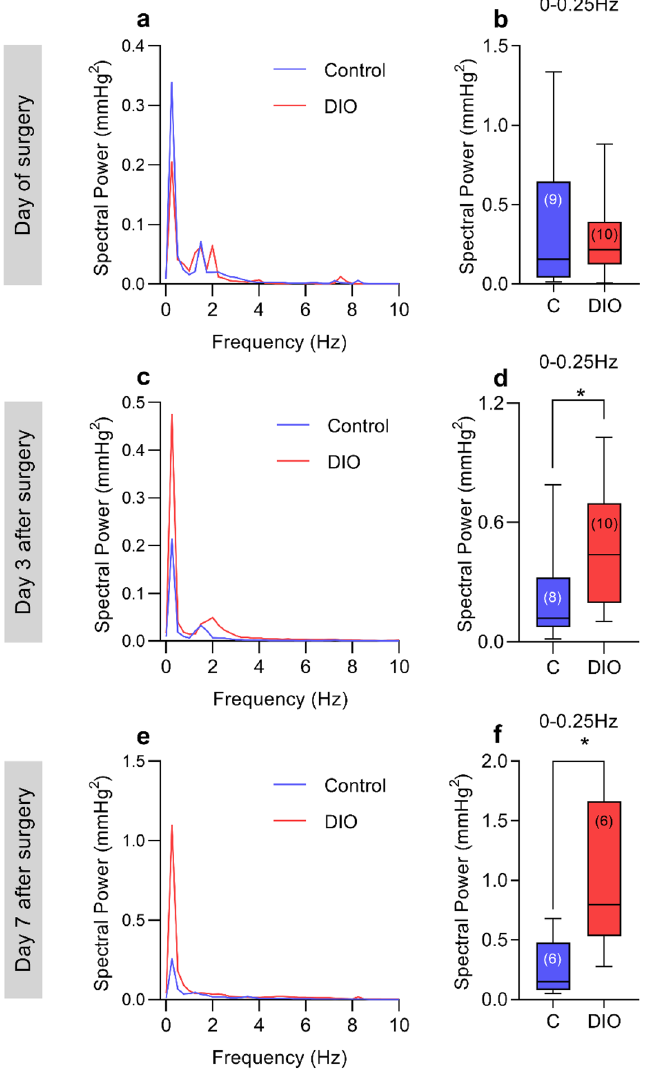
Figure 2. DIO alters ICP waveforms. Fast-Fourier transformation analysis of ICP waveforms between control and DIO rats. Power spectrum of ICP on day 0 ( a ) 3 days after surgery ( c ) and 7 days after surgery ( e ), condensed into 0.25 Hz bins. Spectral power of slow ICP waves on day 0 ( b ), 3 days after surgery ( d ) and 7 days after surgery ( f ). N for each time point can be found in parentheses in the figure. Mann–Whitney U-tests for ( b,d,f ). *P < 0.05. Data presented as mean for ( a,c,e ), median (interquartile range) for ( b,d,f